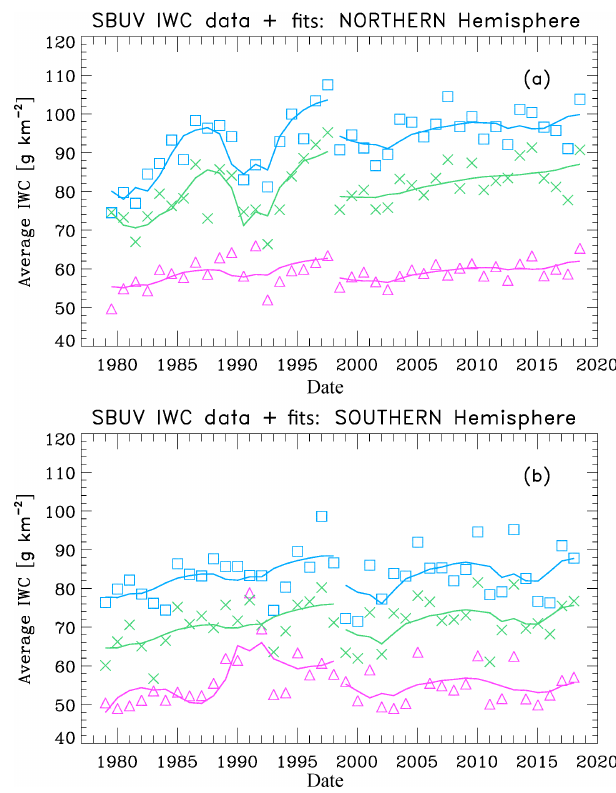
Figure 7. (a) SBUV merged seasonal average IWC values for three different latitude bands: 50–64 ◦ N (purple triangles), 64– 74 ◦ N (green crosses) and 74–82 ◦ N (blue squares). The solid lines show multiple regression fits to the data for the periods 1979–1997 and 1998–2018. (b) SBUV merged seasonal average IWC values for 50–64, 64–74, and 74–82 ◦ S. The solid lines show fits for the periods 1979–1997 and